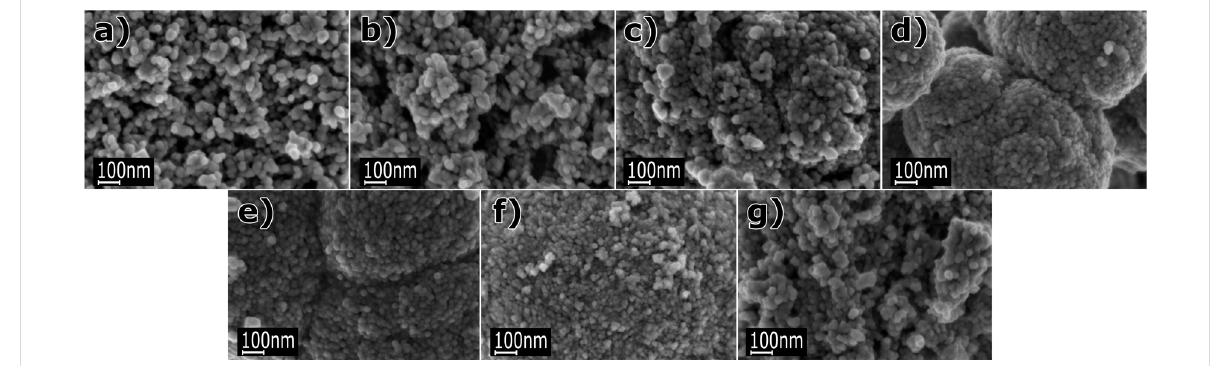
Figure 3: SEM images of NPs of Zn 1 − x Mn x O with dopant concentrations of: a) 0 mol %, b) 1 mol %, c) 5 mol %, d) 10 mol %, e) 15 mol %, f) 20 mol % and g) 25 mol %.